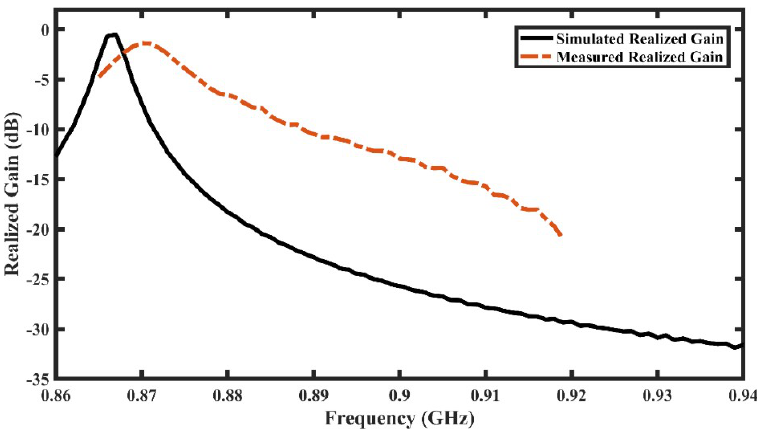
Figure 8. The simulated and measured realized gains of the tag antenna.